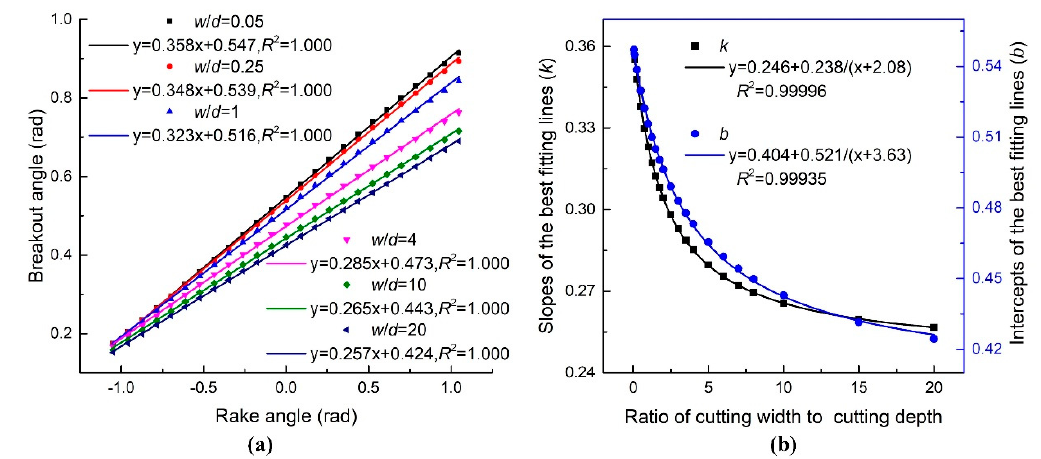
Figure 6. ( a ) Relationship between breakout angle and rake angle at different ratios of cutting width to cutting depth; and ( b ) relationship of the slopes and intercepts to the ratio of the cutting width to cutting depth.